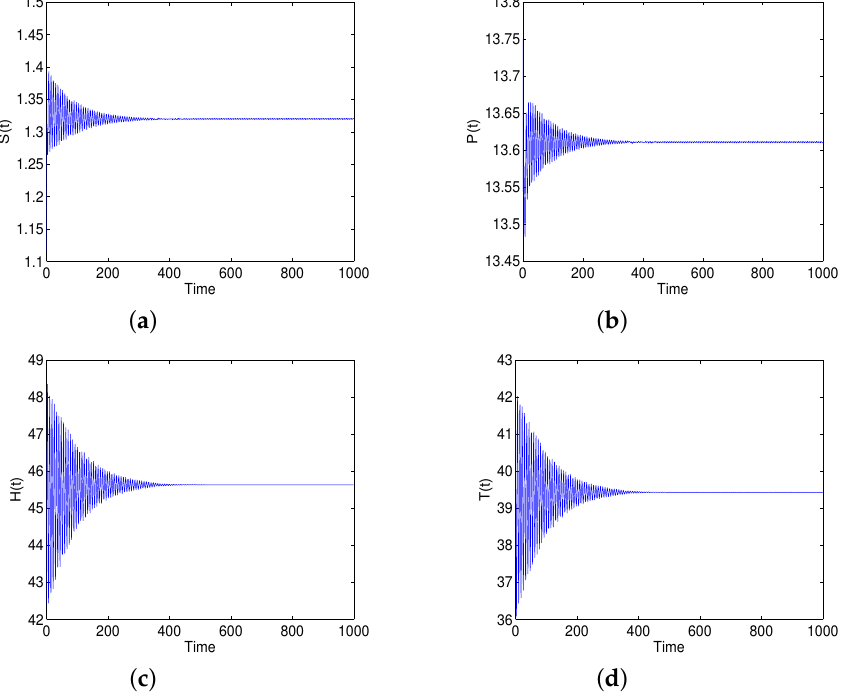
Figure 5. The time plot of ( a ) susceptible population, ( b ) psychological addicts, ( c ) physiological addicts and ( d ) drug-users in treatment for τ 1 = 1.3785 < τ 1 ∗ = 1.4096 and τ 2 = 2.5 ∈ ( 0, τ 20 ) with A = 2, d = 0.02, β 1 = 0.016, β 2 = 0.028, π = 0.03, γ = 0.095, θ = 0.5 and σ =